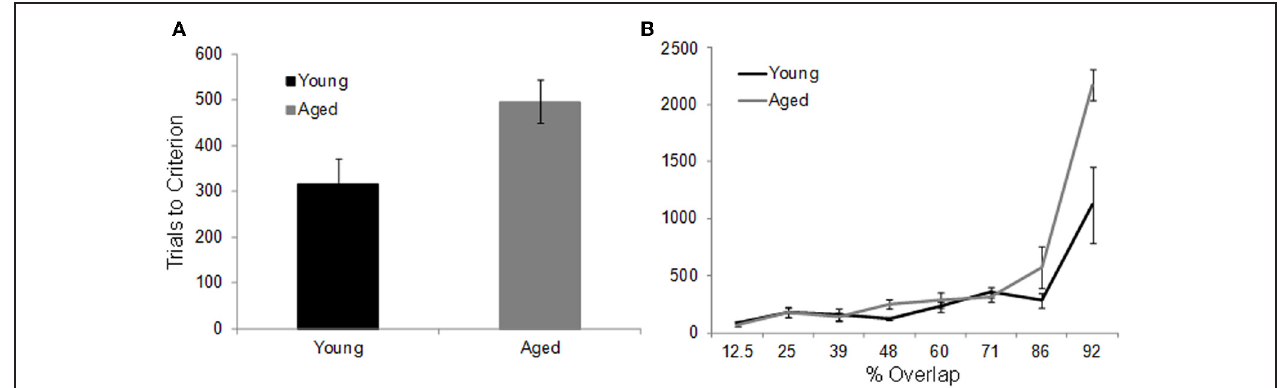
FIGURE 7 | The effect of feature overlap on two-choice object discrimination (OD) task performance. (A) The mean number of trials required for young (black) and aged (gray) monkeys to reach performance criterion of 90% correct on the two-choice OD task when the object pairs shared features. It took the aged monkeys significant more trials to learn which object was rewarded. (B) The mean number of trials to criterion